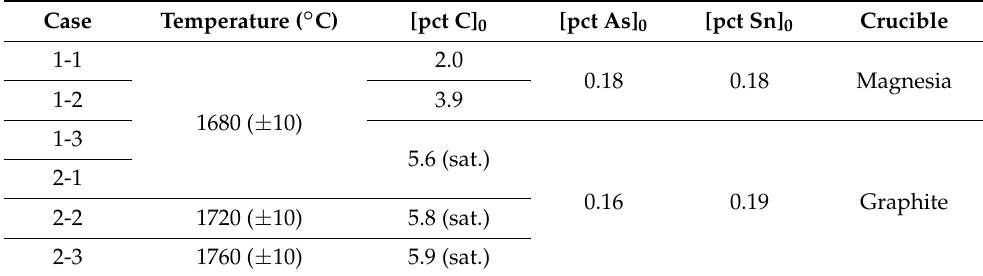
Table 1. Initial composition of the samples ([pct M] 0 ) used in the present